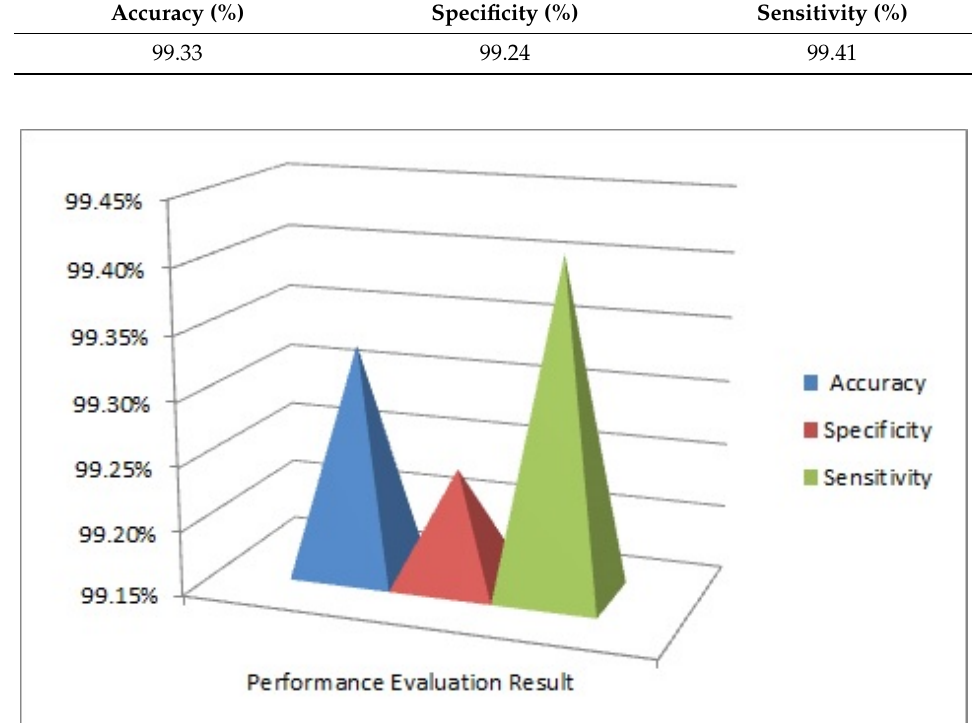
Table 7. Performance evaluation result.